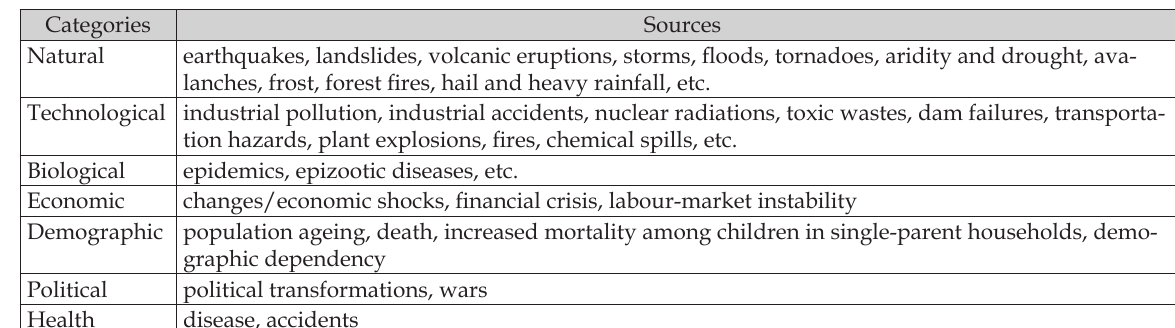
Table 2. Sources of social